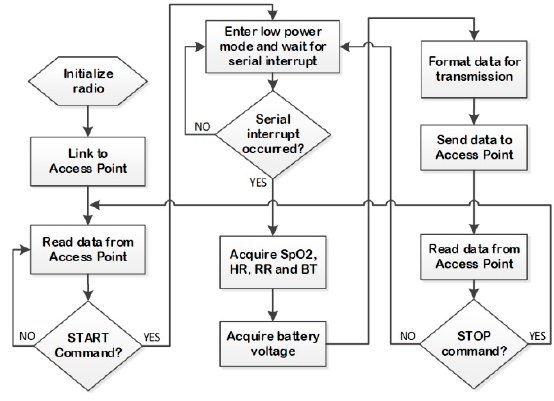
Figure 10. Flowchart of firmware running on MSP430F2274.